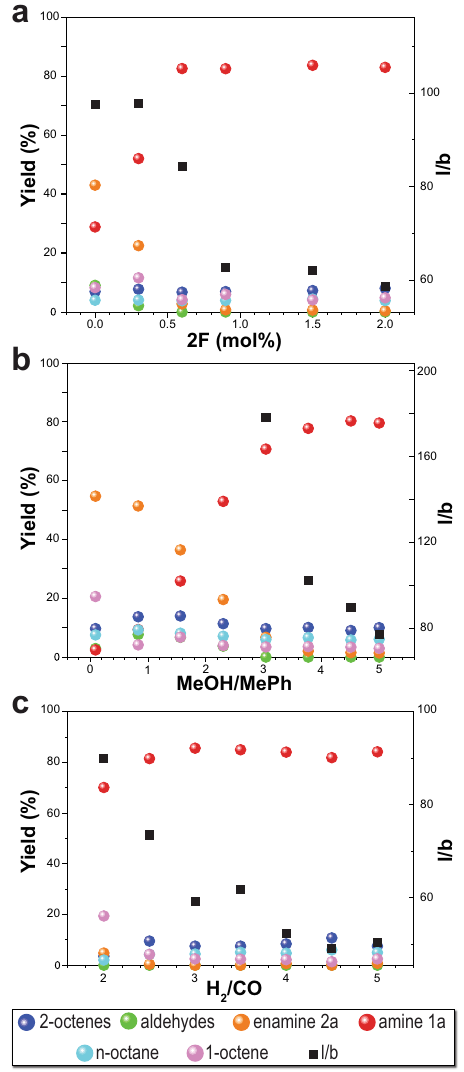
Fig. 3 In- fl ow reaction optimization. Optimization of the HAM reactions for a 2F loading at MeOH:MePh volume ratio of 5 and H 2 :CO ratio of 3.5, b MeOH:MePh volumetric ratio at 2 mol% 2F and H 2 :CO ratio of 3.5, and c H 2 :CO ratio at 2 mol% 2F and MeOH:MePh volume ratio of 4. General HAM reaction conditions: 125 °C, 15 min residence time, 24 barg total pressure, 3.5 gas:liquid volumetric ratio, 0.45M 1-octene, 0.1 mol% Rh(acac)(CO) 2 , and 0.4 mol%